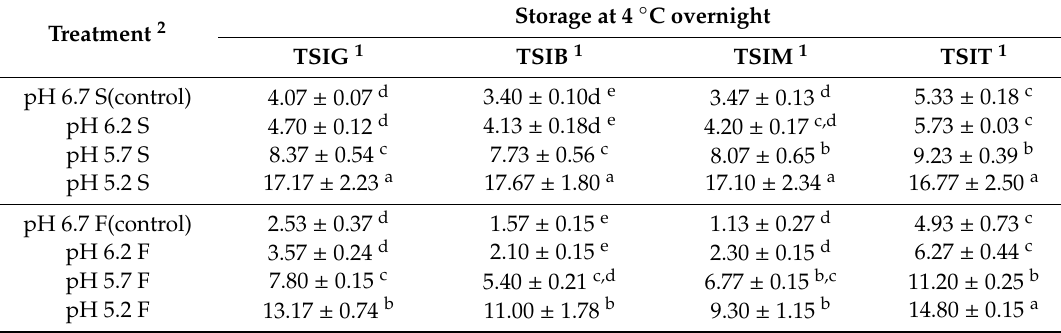
Table 2. The e ff ect of pH on the Turbiscan stability index value in skimmed and full-fat goat milk (replicated for three di ff erent samples). Turbiscan stability index (TSI), TSI-global (TSIG), TSI-bottom